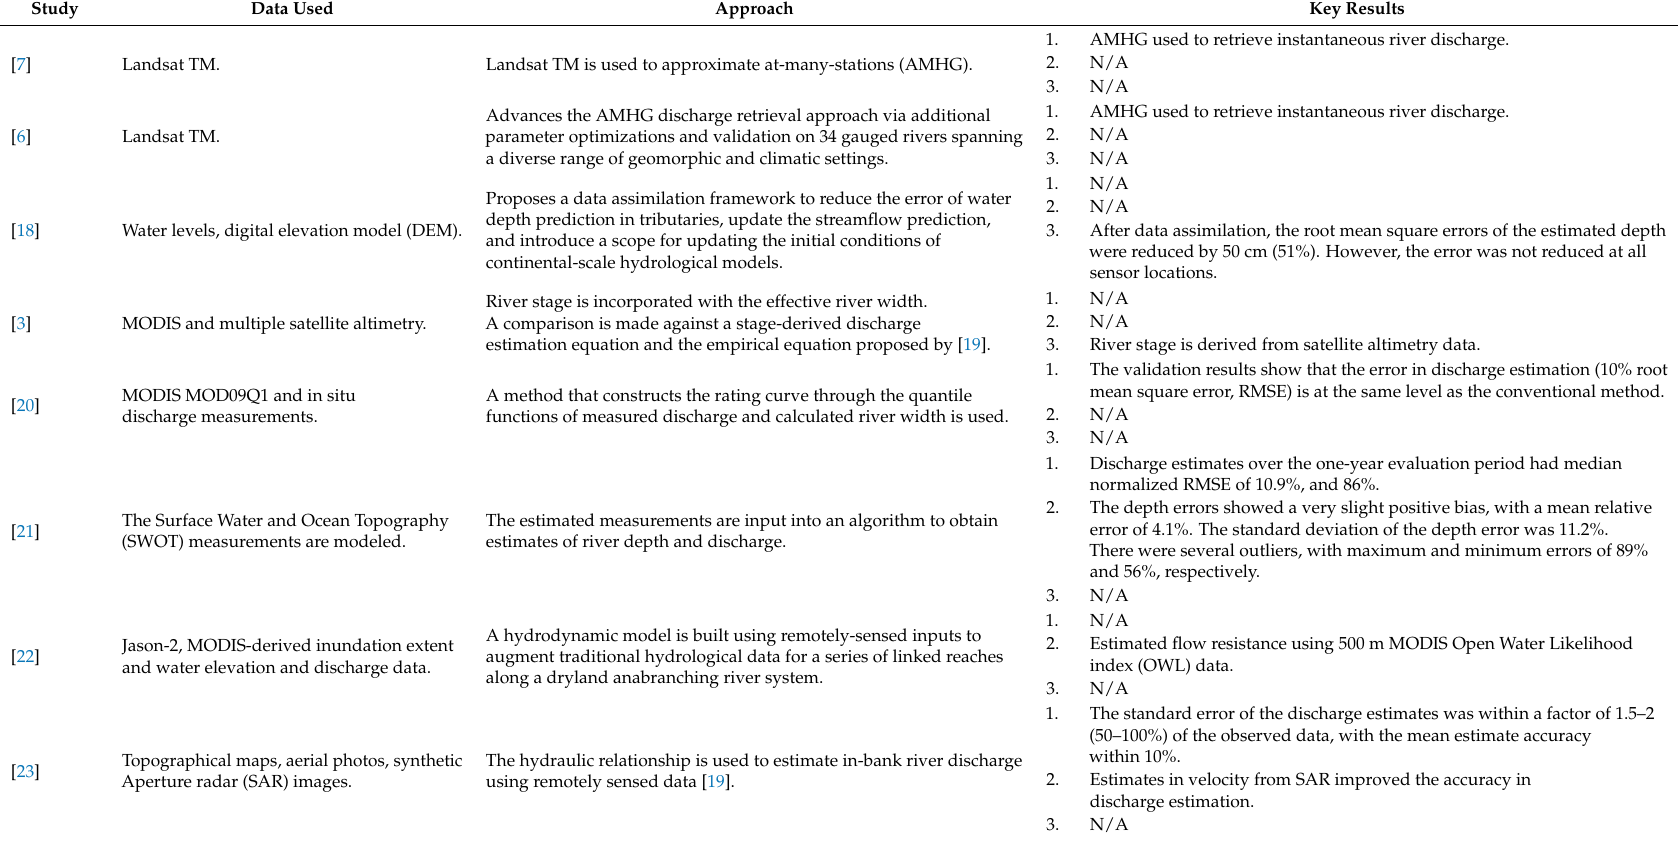
Table 1. A summary of studies using remote sensing to estimate river discharge (the current paper is added for completeness). It is evident that few studies have performed river discharge estimation exclusively from remote-sensing-derived data. In addition, not all studies have estimated river flow using satellite-derived data and not all models can estimate depth by using an empirical relationship between the velocity, slope, and roughness coefficient. In this case, the three are flagged as not applicable (N/A) in the key results. The aforementioned components are coded in the ‘Key Results’ column as: (1) estimate of discharge exclusively from